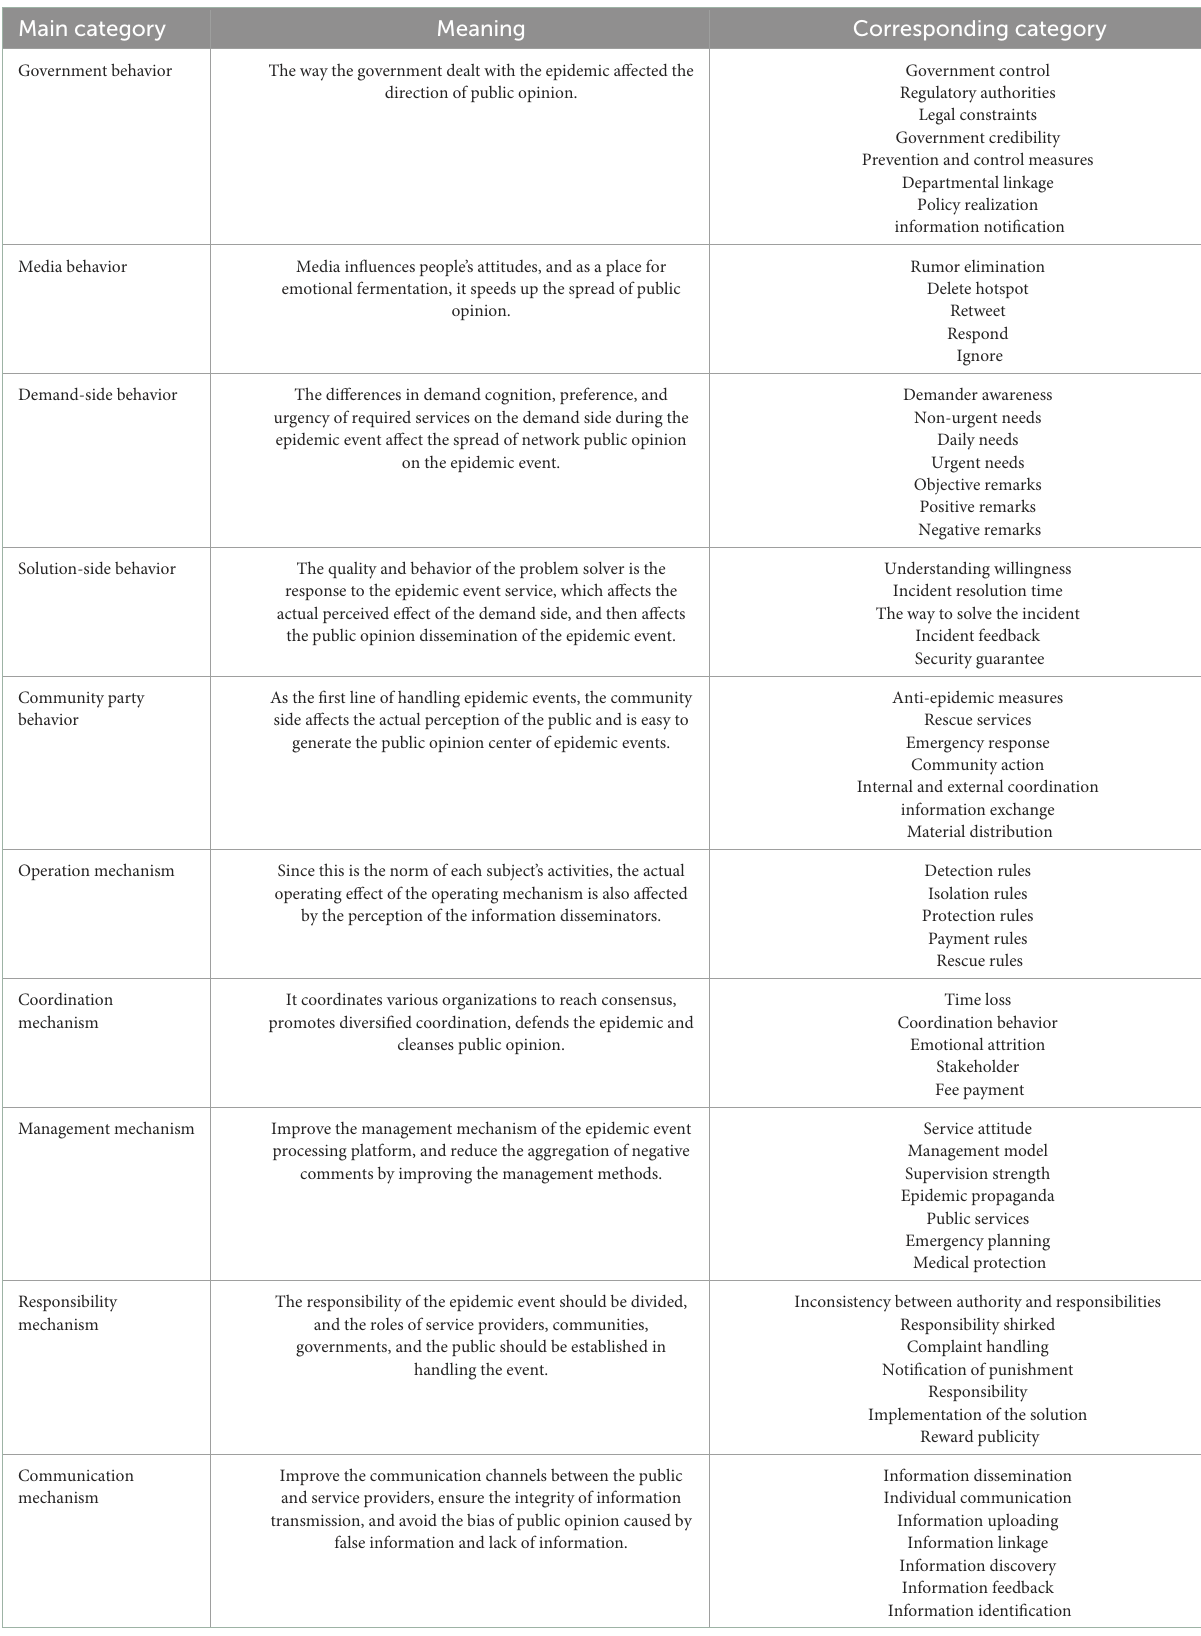
TABLE 2 Axis code